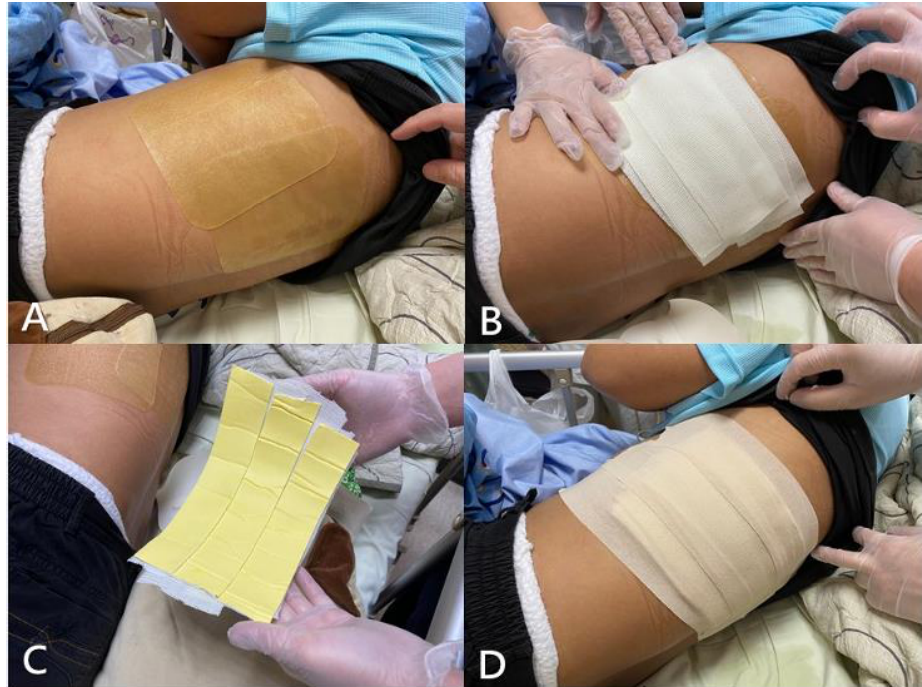
Figure 3. Steps of applying the K-Rod: ( A ) The innermost layer of adhesive hydrocolloid dressing was attached first to protect the skin and with complete coverage of all recognized tender points. ( B ) A six-layered hard splint made of fiberglass casting tape was trimmed and then immersed in water. It was then firmly placed over the injury area for shaping and hardening. ( C ) Once the fiberglass casting tape had hardened, it was detached from the chest wall, and one layer of double-sided foam tape was applied to its inner side. ( D ) The fiberglass casting tape was adhered to the innermost layer by using double-sided foam tape, and all layers were securely fixed using an outermost layer of elastic adhesive tape.